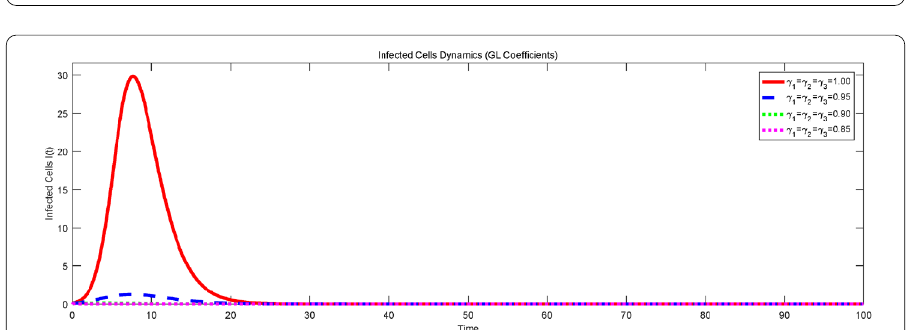
Figure 8 Dynamics of S ( t ) with γ i = 1 (solid red line), γ i = 0.95 (dashed blue line), γ i = 0.9 (dotted green line) and γ i = 0.85 (dotted dashed magenta line), i = 1,2,3.